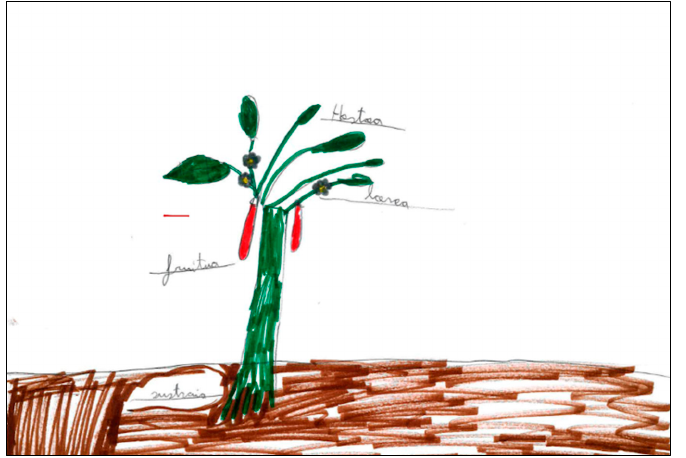
Figure A3. The drawings on the topic of plant that a 6 year old child completed in 2019.